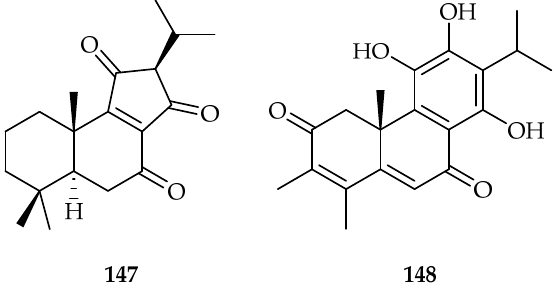
Figure 60. Structure of leriifolione 1 47 [91] and salvimulticanol 148 [92].